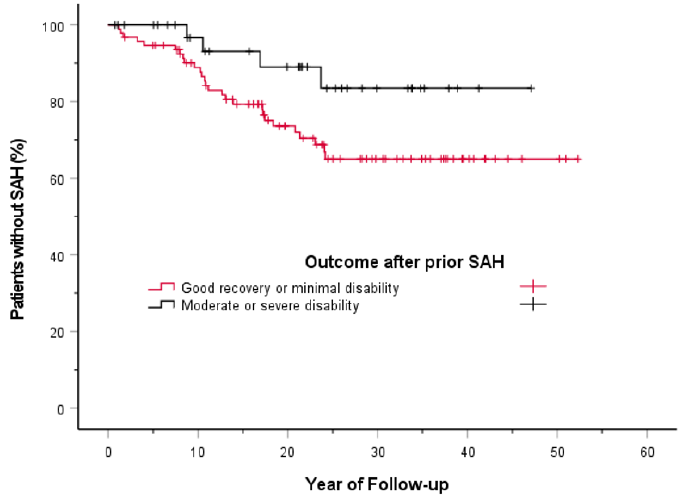
Figure 1. Long-term cumulative aneurysm rupture risk according to outcome after prior subarach- noid hemorrhage (SAH). The markers on the curves indicate censored events. SAH indicates sub- arachnoid hemorrhage. See text for detailed statistics; p = 0.066 for the difference between cumulative aneurysm rupture rates between groups (log-rank test).